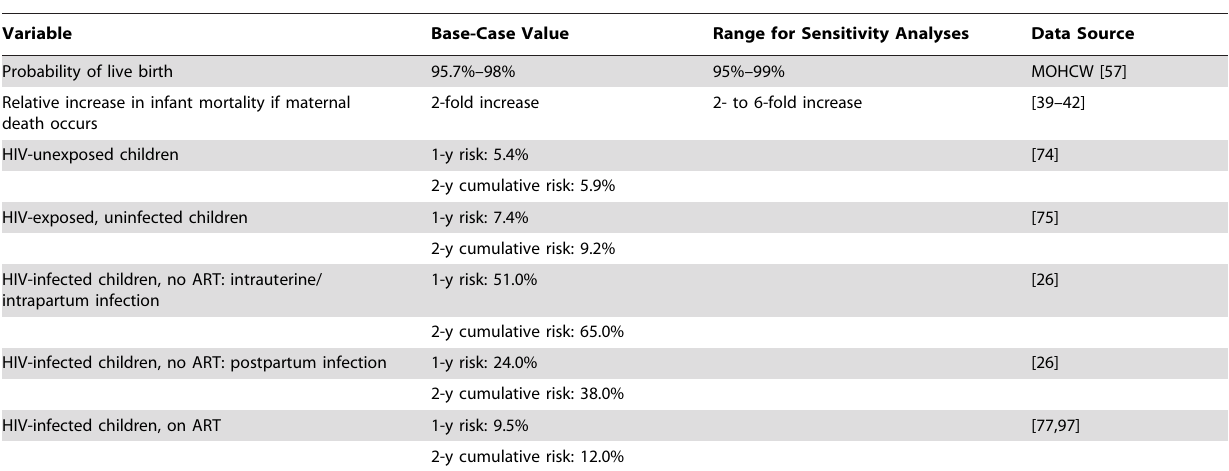
Table 4. Model input parameters: infant mortality.